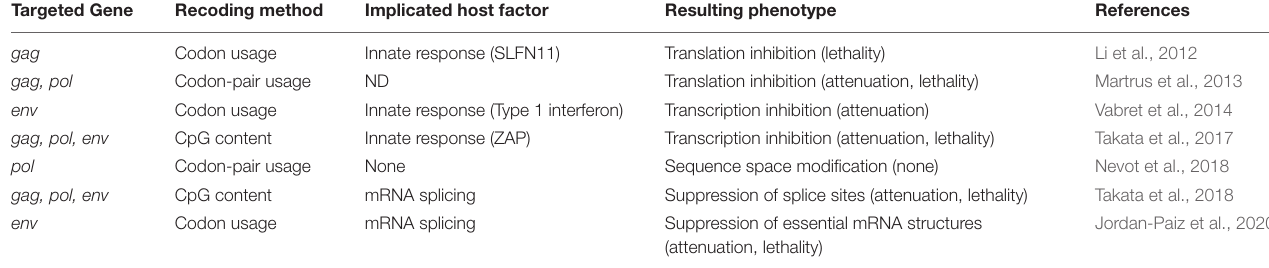
TABLE 1 | Examples of HIV-1/SIV phenotype modification by genome synonymous substitutions.